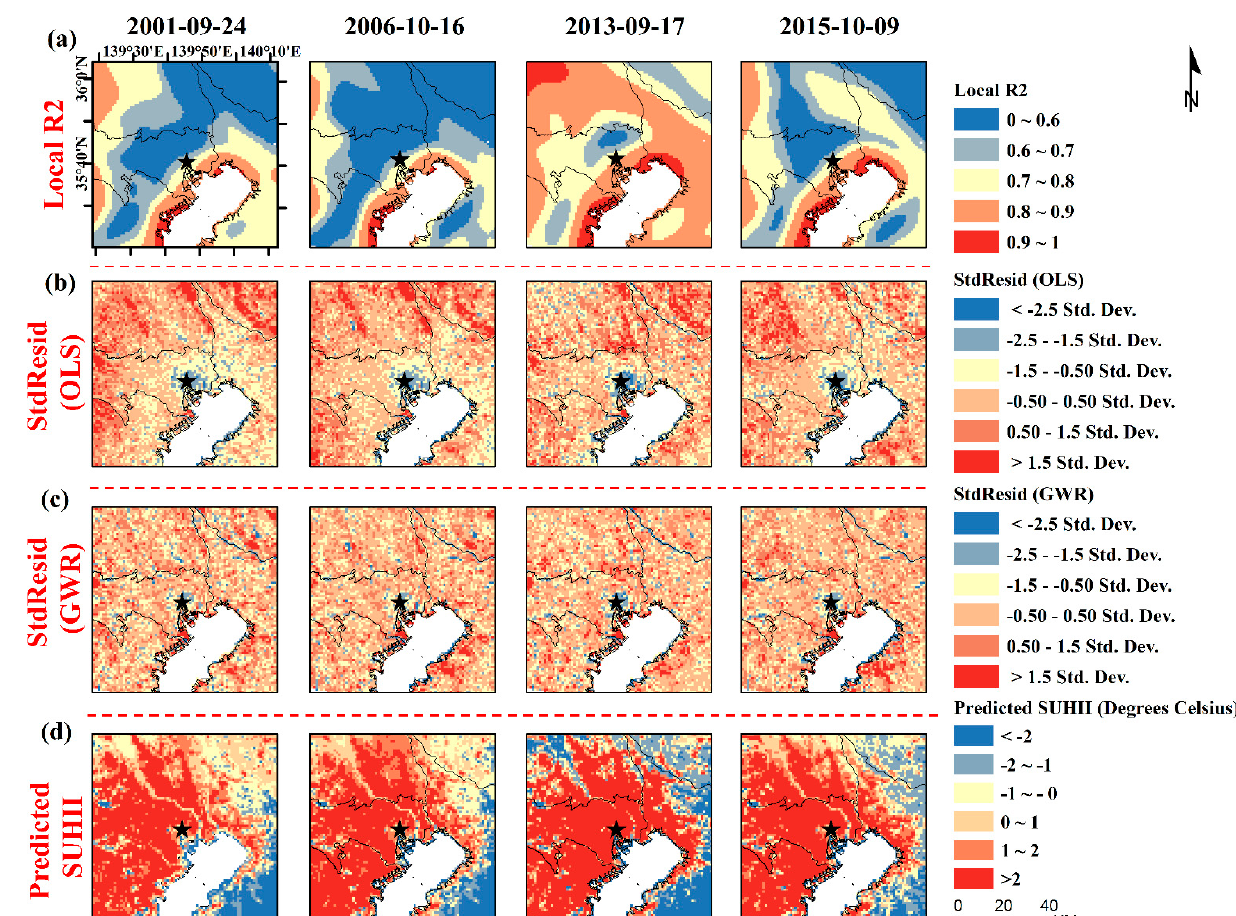
Figure 10. Spatiotemporal variations of local parameters derived from GWR models: ( a ) Local R 2 , ( b ) standardized residual (OLS), ( c ) standardized residual (GWR), and ( d ) predicted SUHII.